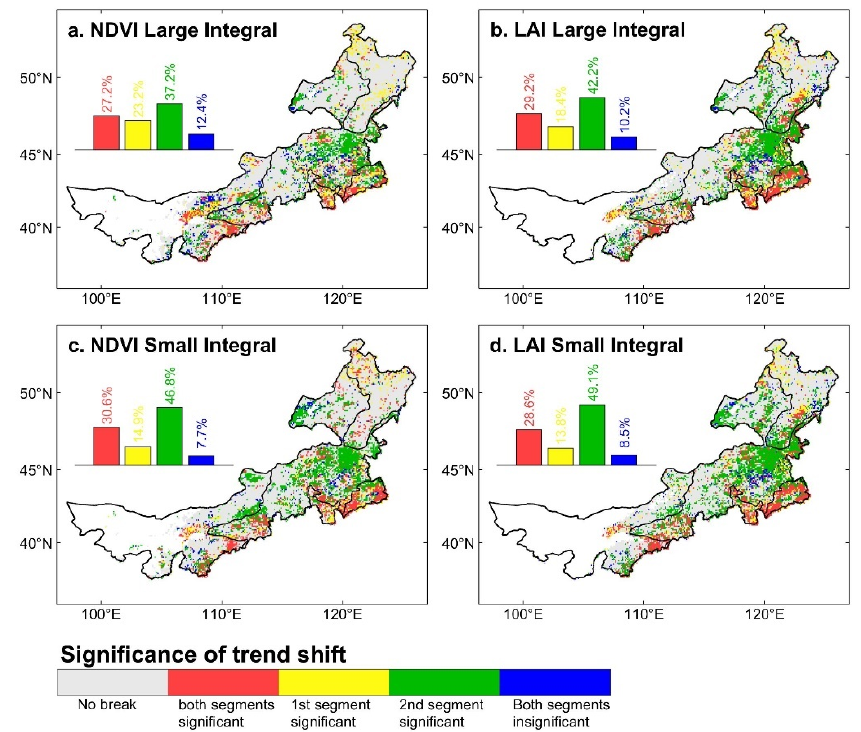
Figure 8. Spatial distributions of the significance of trend shift ( p < 0.05), ( a ) NDVI large integral; ( b ) LAI large integral; ( c ) NDVI small integral; ( d ) LAI small integral. Pixels with no breakpoint are reported in grey while white areas indicate regions with no data (i.e., non-vegetated areas or missing data). The histograms above each map summarize the distribution of four types of significant changes.